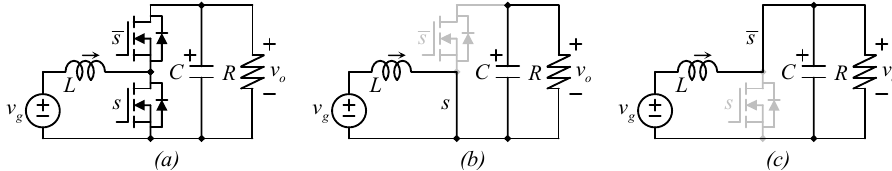
Figure 1. The (boost) power stage ( a ) topology, ( b ) equivalent circuit of the converter when the switch is closed (on), ( c ) equivalent circuit of the converter when the switch is open (off).